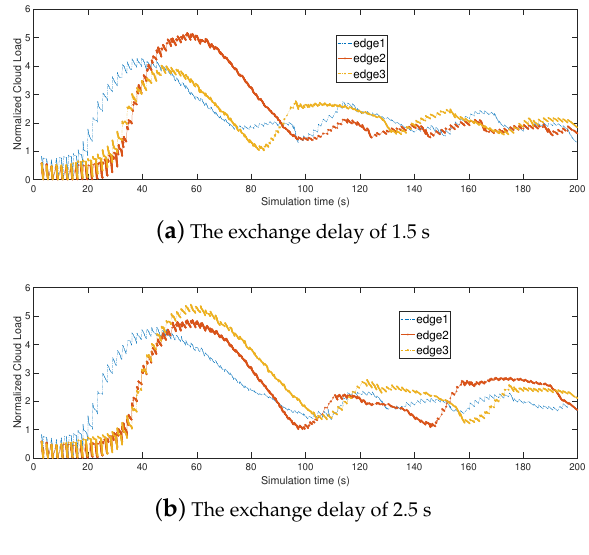
( b ) The exchange delay of 2.5 s Figure 10.